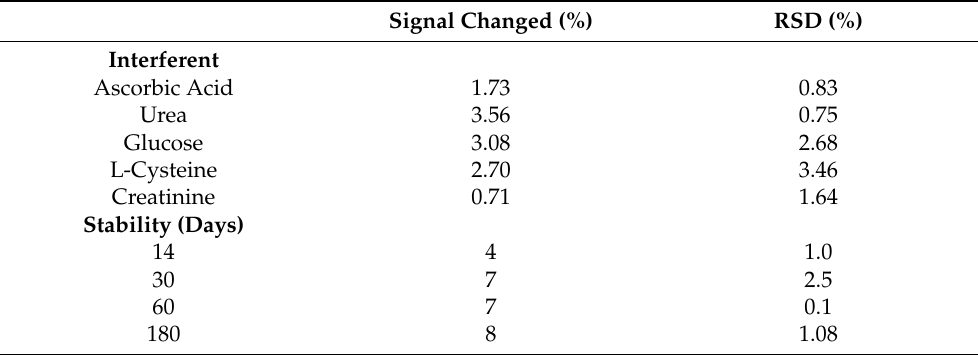
Table 4. Representative data of magnitude current changes during uric acid detection with the presence of several interferents at the same fold concentration (22 µ M) in 0.1 M PBS solution at pH 7.4 and the mp20@ZIF-8/rGO/SPCE biosensor stability over